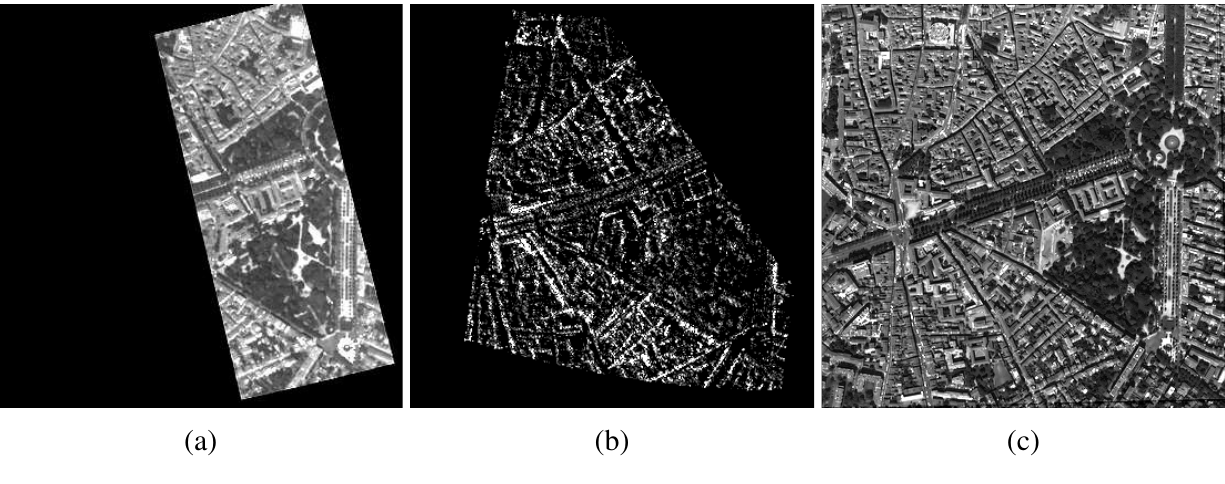
Figure 2. Toulouse data set: (a) push-broom, (b) SAR and (c) XS